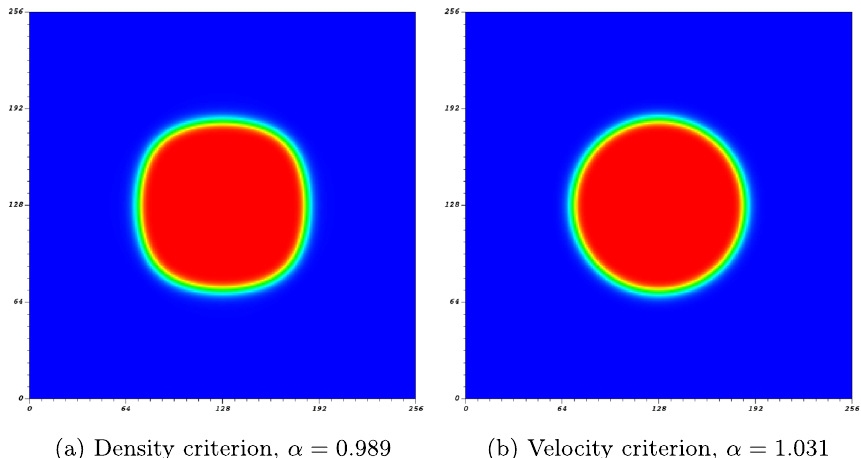
Fig. 6 Density contours produced by DUGKS on different criteria, τ = 0.75 , T r =